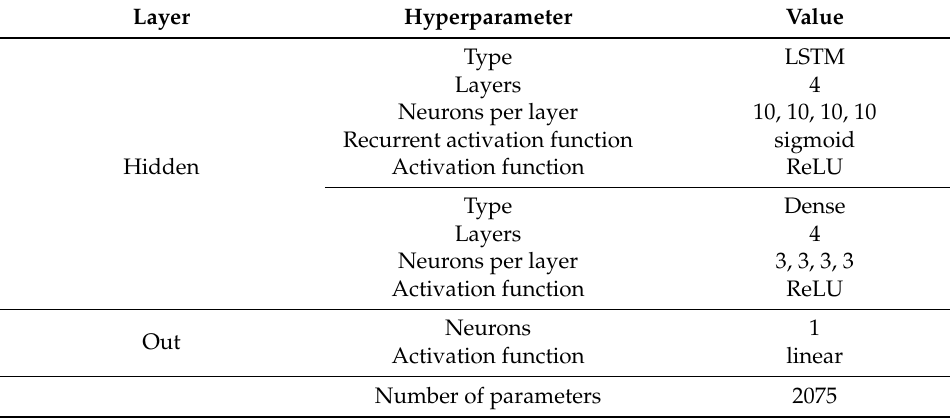
Table 9. Muñoz’s architecture hyperparameters